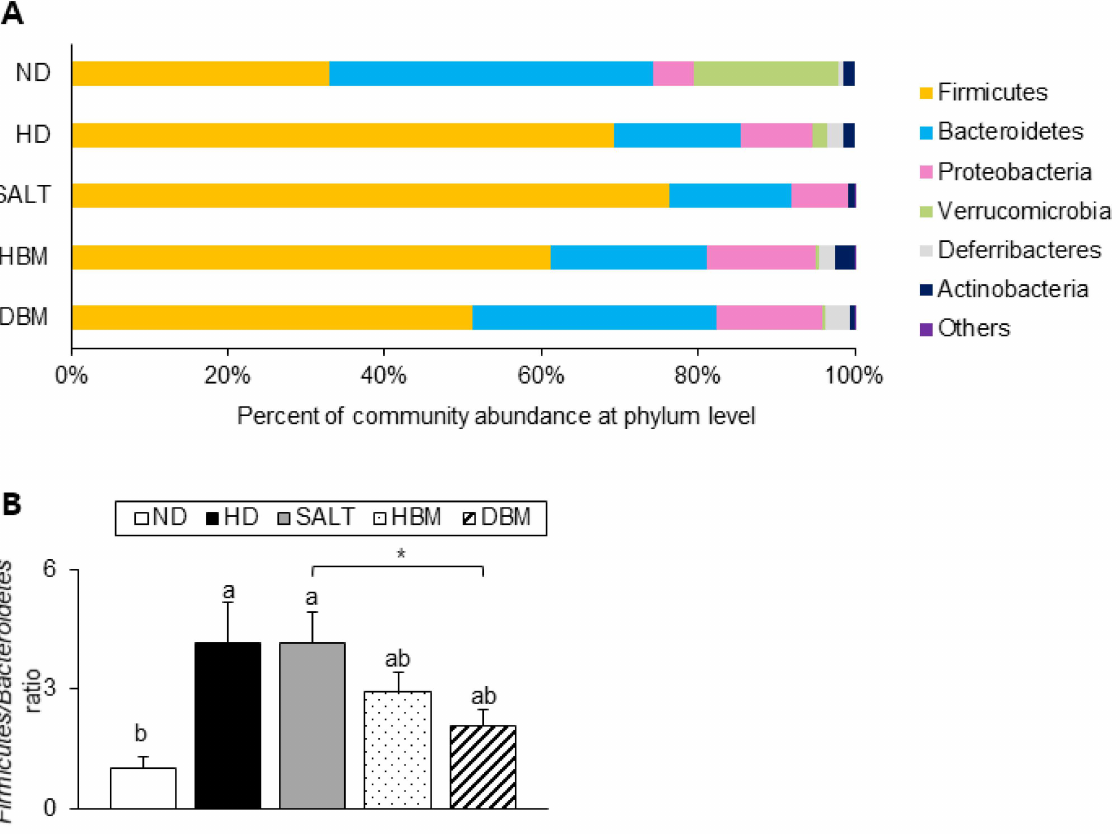
Figure 7. Effect of Gochujang on the population structure of gut microbiota at phylum level in the HD-fed mice. ( A ) Microbial community at the phylum level in mice; ( B ) Firmicutes -to Bacteroidetes ratio in mice. Values are mean ± SEM. a–b means with the different letters on the bar ( p < 0.05). (a > b). * p < 0.05. ND, normal diet group; HD, high-fat diet group; SALT, HD with 0.7% salt group; HBM, HD with 10% of HBM Gochujang group; DBM, HD with 10% of DBM Gochujang